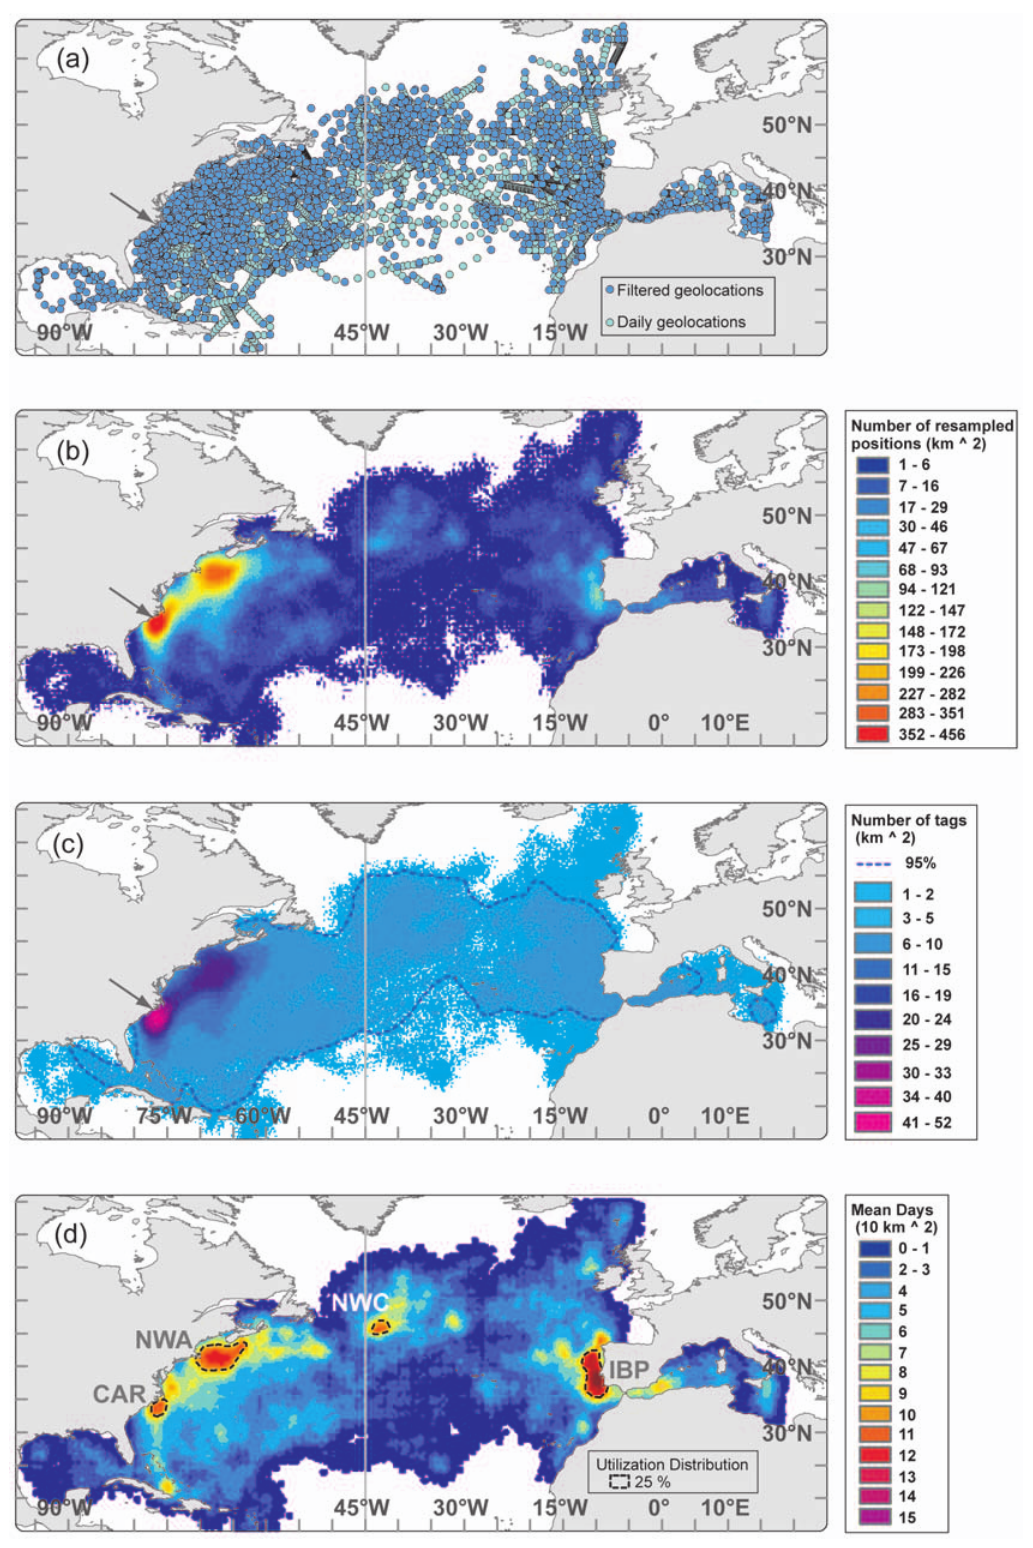
Figure 3. Maps showing calculation of utilization distribution from pooled geolocation tracks. Dark grey line at 45 u meridian indicates management line. (a) Blue circles are all deployment, daily geolocation and recapture positions (n=7,793) from 106 bluefin tuna between 1996–2006 and light blue circles indicate daily, linearly interpolated positions (n=14,716) (b) Kernel density grid of resampled daily positions (n=1,471,600). (c) Grid of number of bluefin tuna tracked per square kilometer. Blue line outlines area of $ 3 tags. (d) Normalized kernel density grid of number of daily geolocations weighted by number of fish tracked per unit area. Black, dotted line outlines 25% utilization distributions, showing four regions of high residency throughout the North Atlantic. doi:10.1371/journal.pone.0006151.g003 PLoS ONE | www.plosone.org